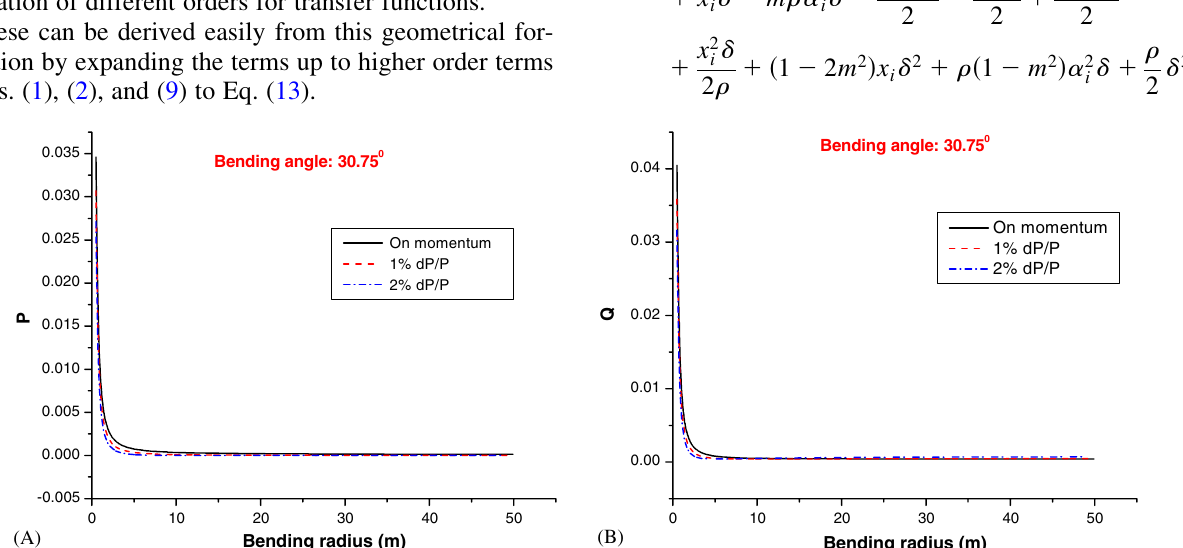
FIG. 7. Variation in P and Q with bending radius for fixed bending angle of 30.75 (cid:3) . The x i and (cid:3) i are taken as 100 mm and 20 mrad,